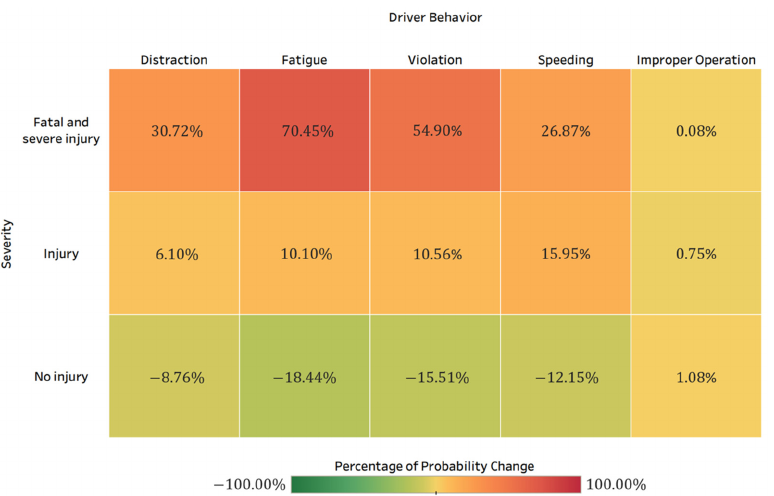
Figure 5. Percentage of probability change for HAZMAT crash severity when setting evidence for driver behavior factors.